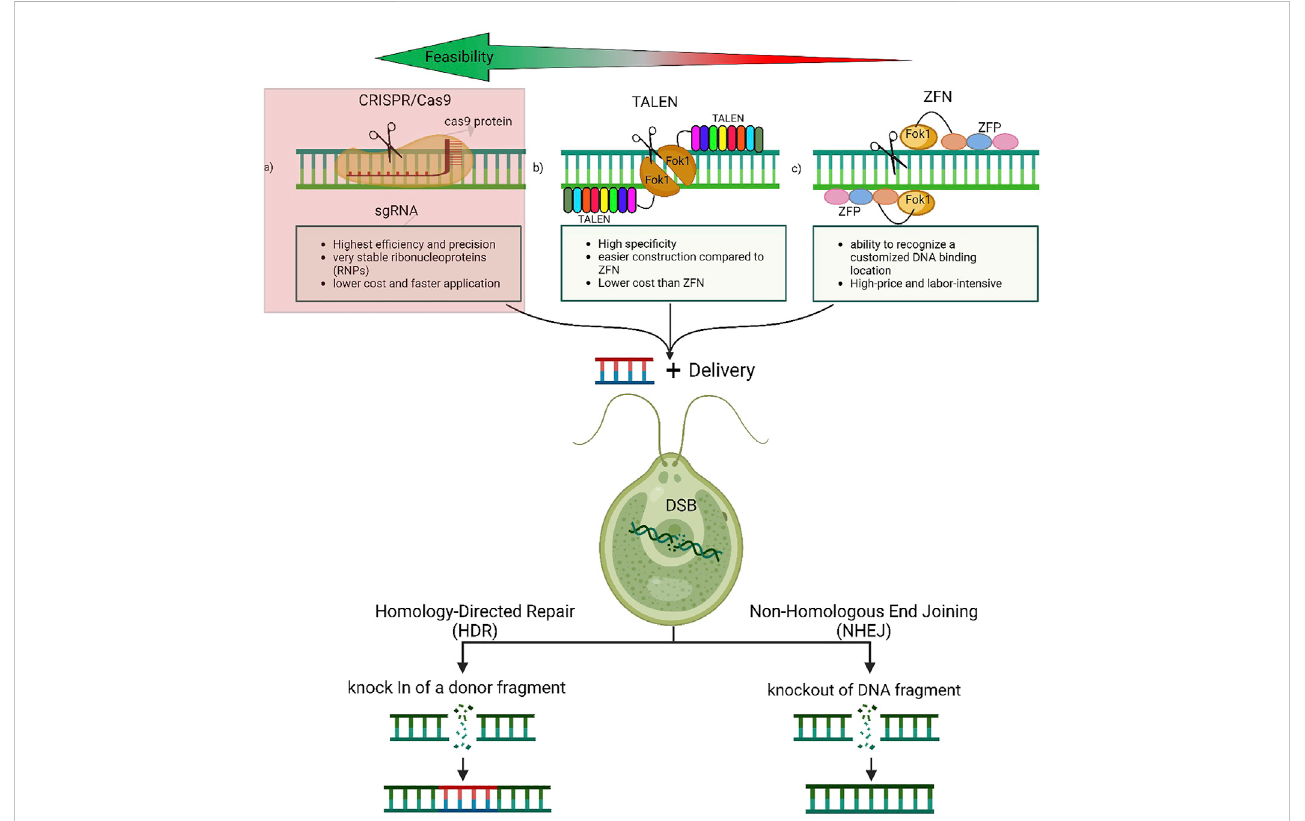
FIGURE 2 Genetic engineering tools-induced genome editing in Microalgae. The double-stranded breaks (DSBs) introduced at the target site by CRISPR/Cas or TALEN or ZFN complexes stimulates the endogenous DNA repair machineries, non-homologous end joining (NHEJ) in the absence of the donor template or thehomology-directed repair(HDR) inpresenceof thedonortemplate. The NHEJisgenerallyassociated with theintroduction ofinsertions and/ordeletions (indels) of varying lengths at the DSB site, often leading to the disruption of the reading frame of the target gene. The HDR pathway results in a precise insertion or deletion at the DSB site by homologous recombination. The preferred tool is the CRISPR/Cas9 which is highlighted in red as it is very accurate, easy, and